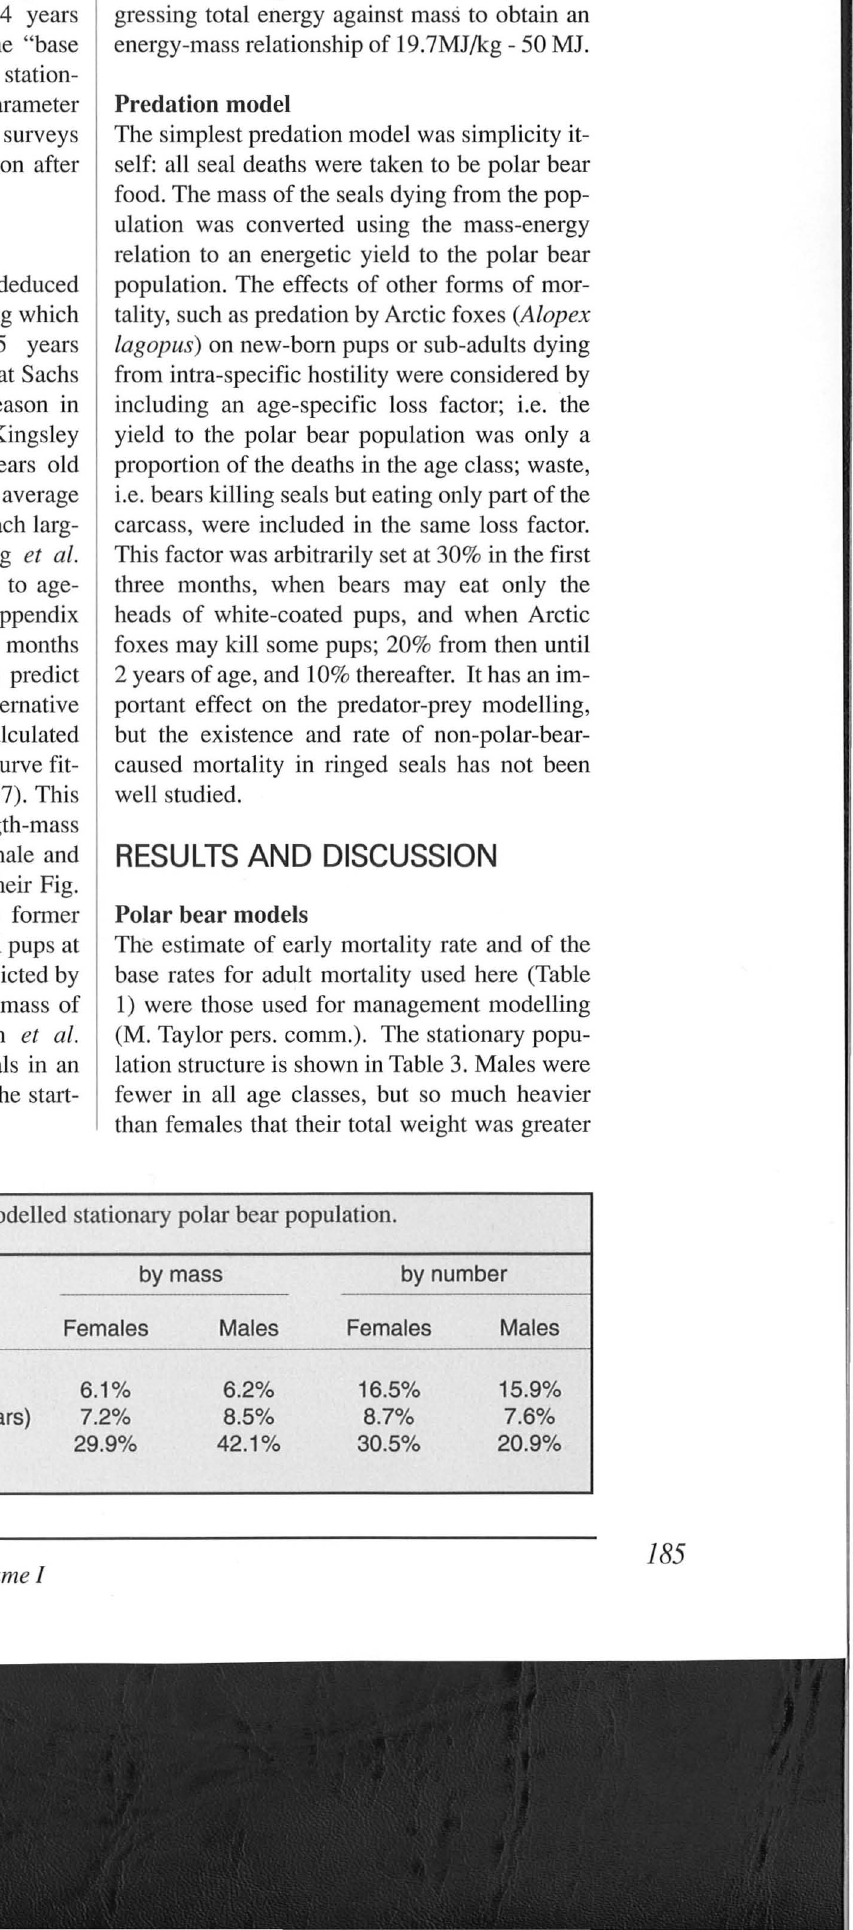
Table 3. Age and sex structure of a modelled stationary polar bear